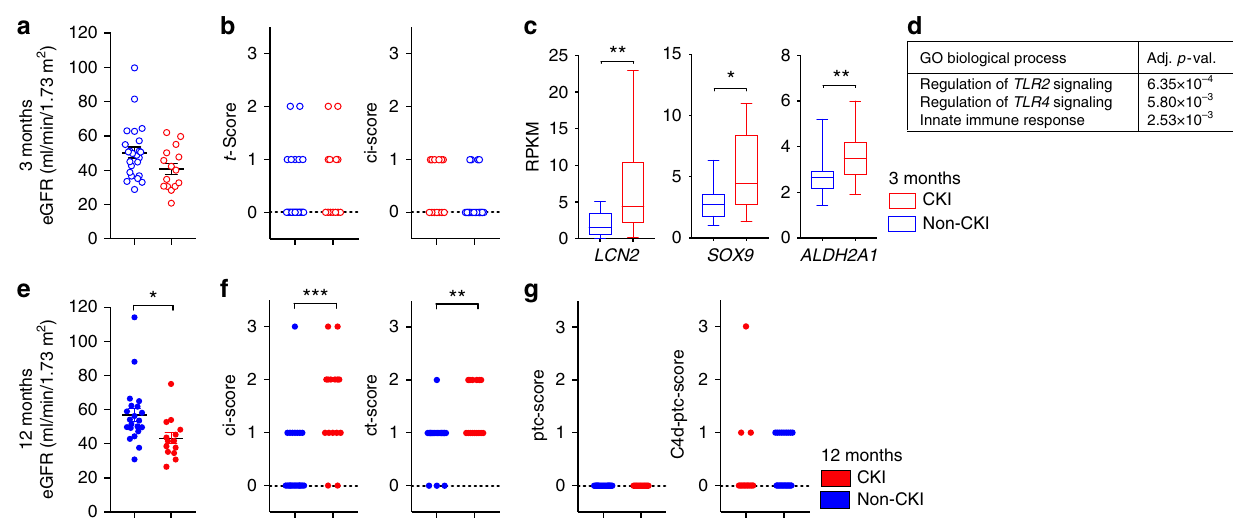
Fig. 2 B cell action following tissue injury in human allografts. a , e Scatter plot showing the estimated glomerular fi ltration rate (eGFR) at 3 months ( a , N = 41) and 12 months ( e , N = 39) in kidney transplant recipients classi fi ed in the CKI and non-CKI group at 12 months. Unpaired t test, * P < 0.05. b , f , g Scatter plots showing the histological evaluation of protocol biopsies according to Banff at 3 months ( b ) and 12 months ( f , g ). t acute tubular lesions, ci chronic interstitial lesions, ct chronic tubular lesions, ptc peritubular capillaritis, C4d-ptc Cd4 positivity in peritubular capillaries. Mann – Whitney test, ** P < 0.01. c Histograms showing mean RPKM values and SE of representative genes related to kidney injury and repair from kidney biopsies collected at 3 months after transplantation. Mann – Whitney test, * P < 0.05, ** P < 0.01. Red symbols indicate patients of the CKI-group, blue symbols of the non-CKI group. Empty and fi lled symbols show data acquired at 3 and 12 months after transplantation, as indicated. d Gene enrichment analysis including genes with a higher expression in the MIR group at 3 months, among genes previously associated with acute rejection episodes. P values adjusted according